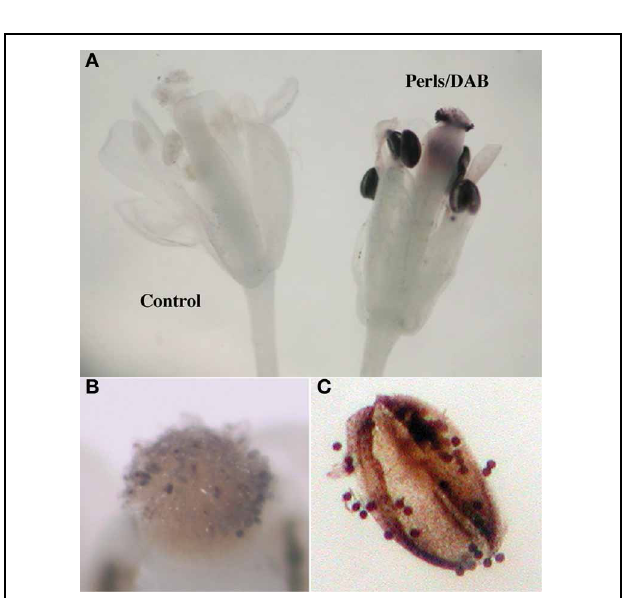
FIGURE 5 | Arabidopsis flowers stained with Perls/DAB. (A) Open mature flowers, (B) stigmatic papillae with sticking pollen grains, (C) anther with mature pollen